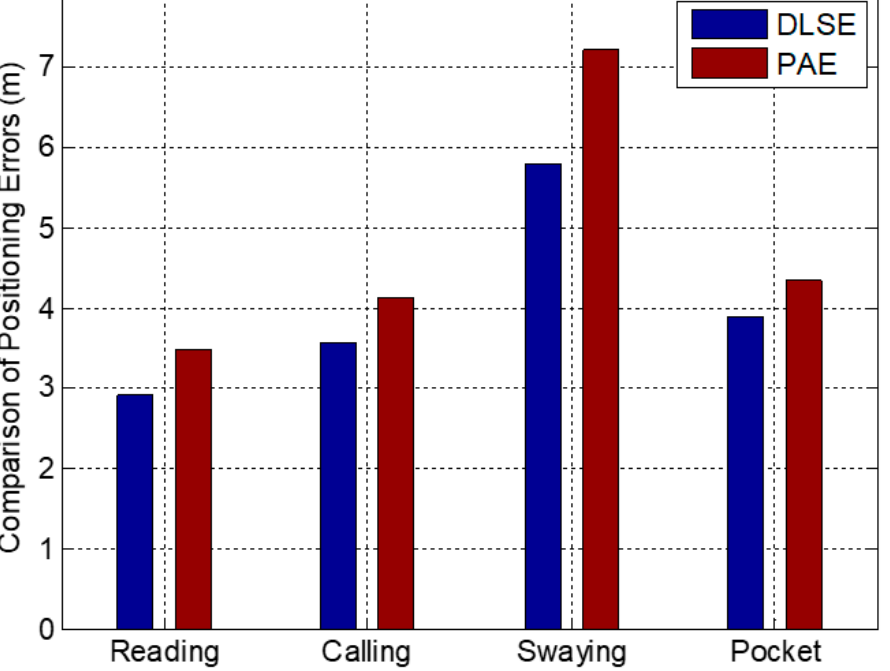
Figure 7. Error Comparison Under Different Handheld